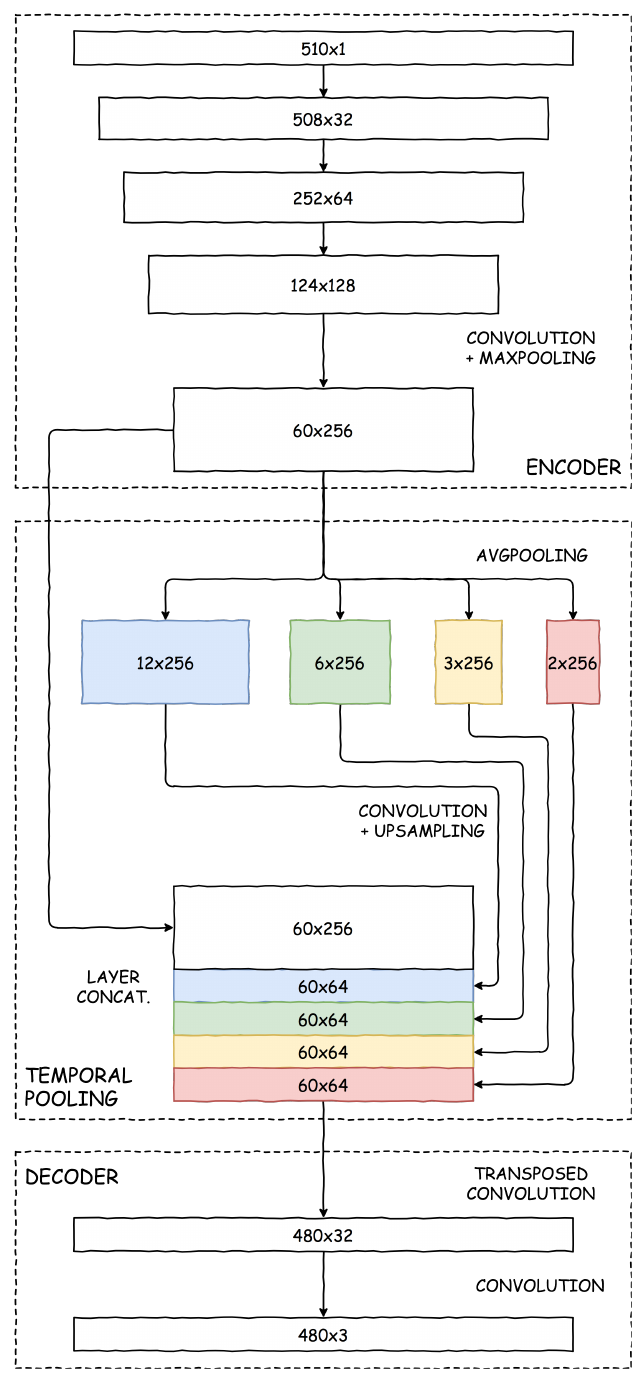
Figure 1. Outline of the network architecture used. See text in Section 3 for